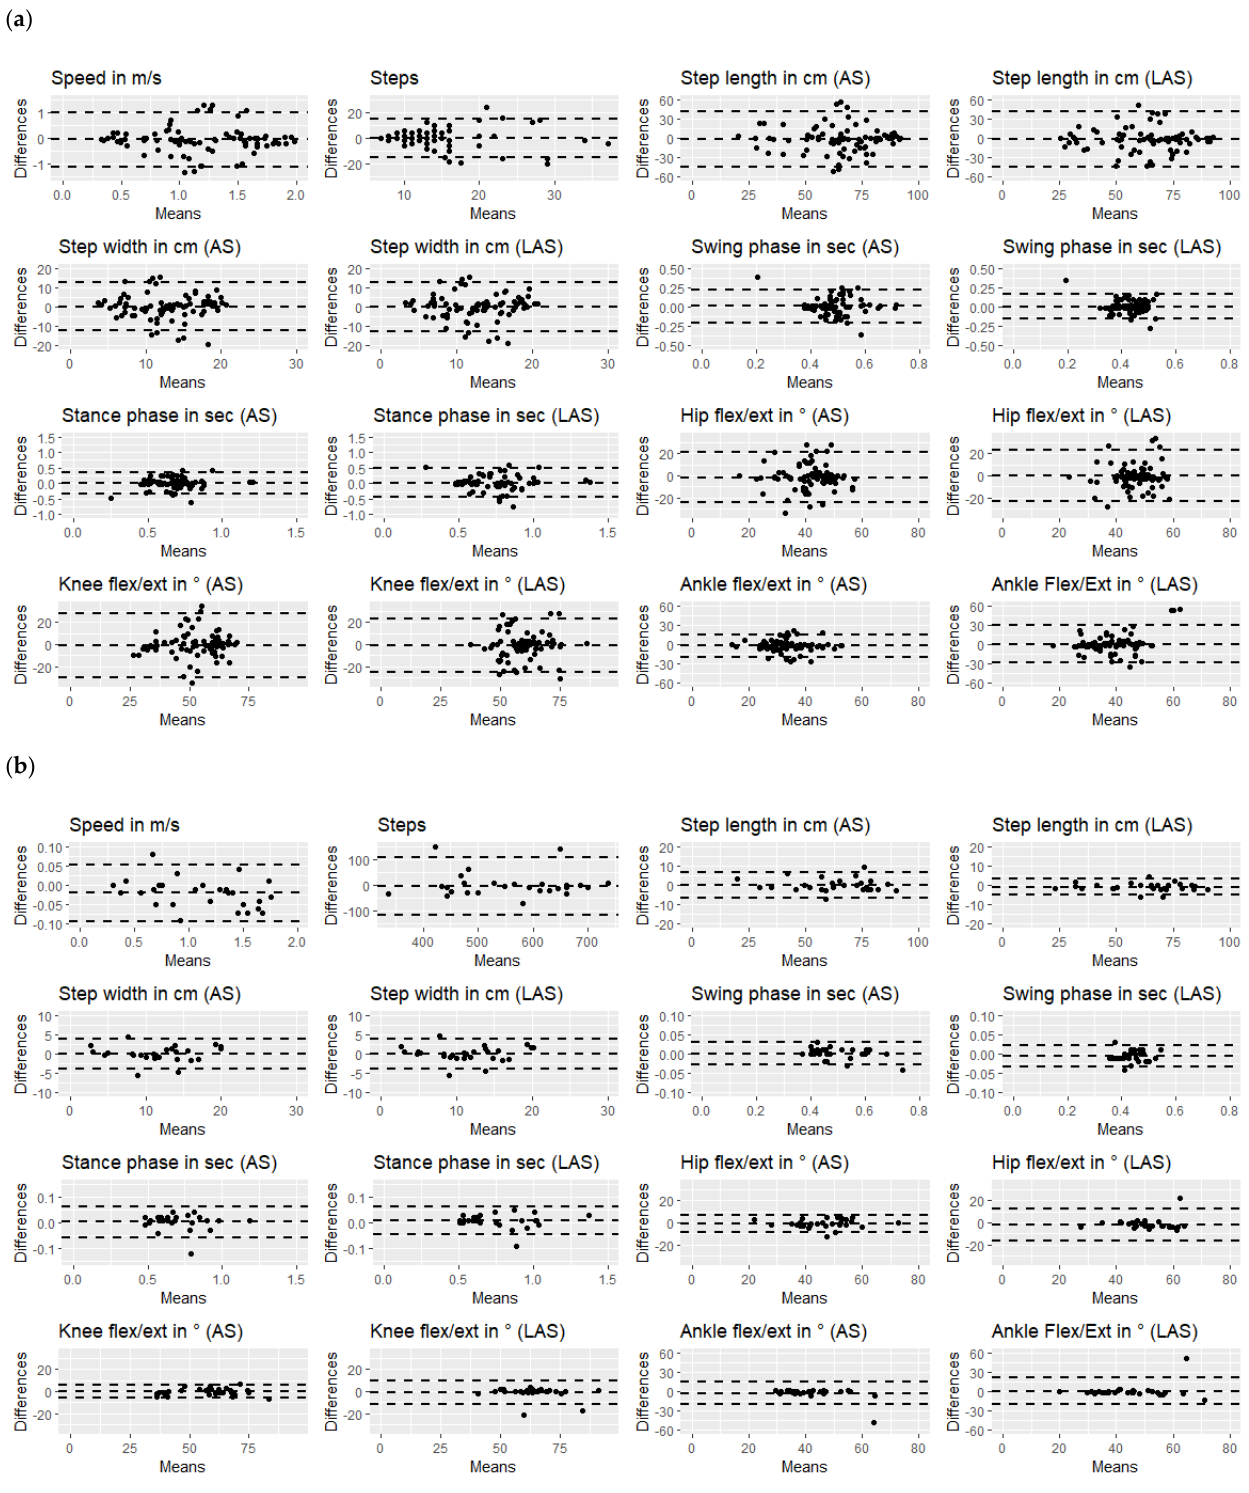
Figure 2. Bland Altman plots per gait metric during ( a ) 10MWT and ( b )